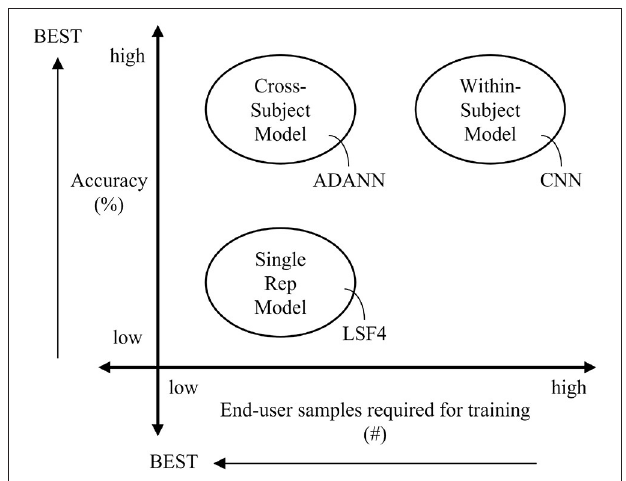
FIGURE 4 | Summary of the results found in this paper, where the best performing model for each classification framework was specified. The ideal conditions for a classification model are indicated using